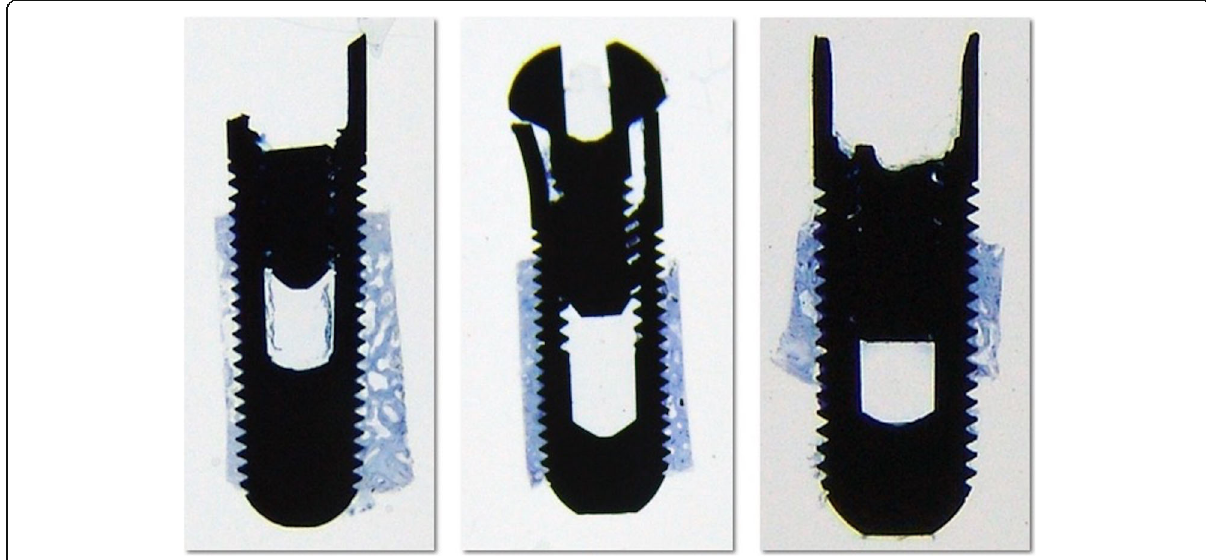
Fig. 2 General overview of sandblasted and acid-etched implant histologic section. Note the presence of abutment screws and the internal hexagon walls which are fractured, and high bone density within threads of implant (toluidine blue, original magnification × 1.5)